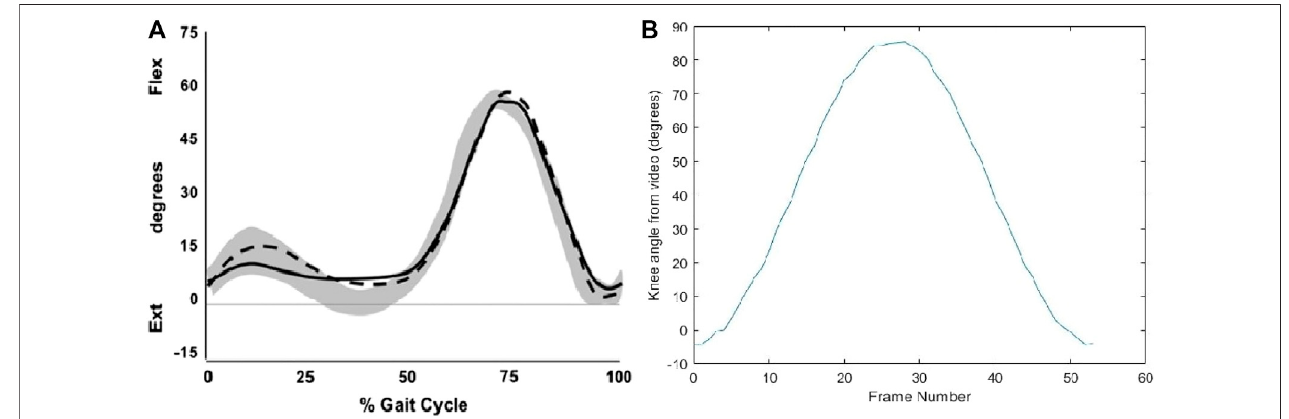
FIGURE 9 | (A) Range of motion of knee during normal gait cycle (Martin et al., 2013), (B) Range of motion of fabricated knee joint exoskeleton.